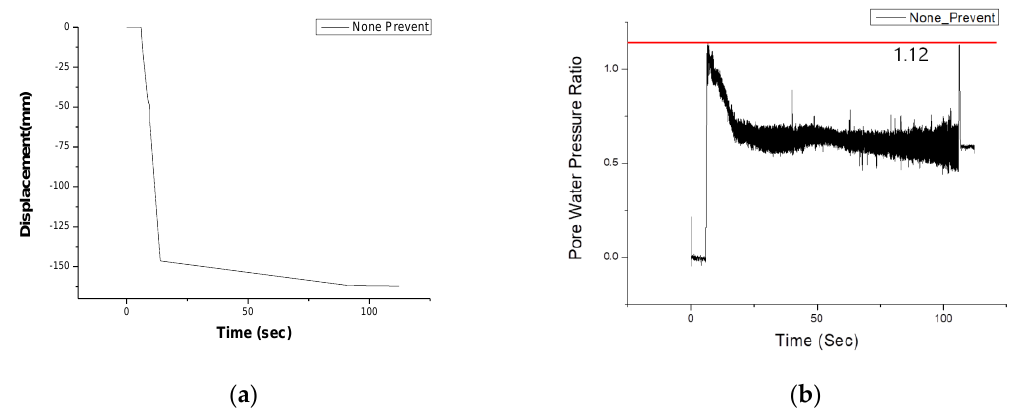
Figure 6. Non-reinforced: ( a ) Settlement ( b ) Pore Water Pressure Ratio.